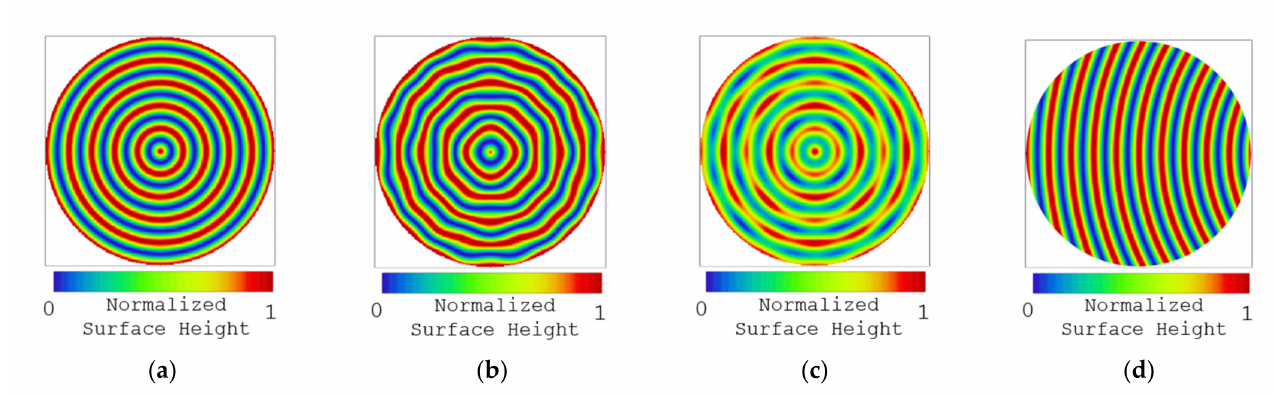
Figure 4. Examples of tooling mark manifestations. All surface heights normalized. ( a ) Radial TMs; ( b ) Radial & In-plane TMs; ( c ) Radial & Out-of-plane TMs; ( d ) Off-axis Radial TMs.